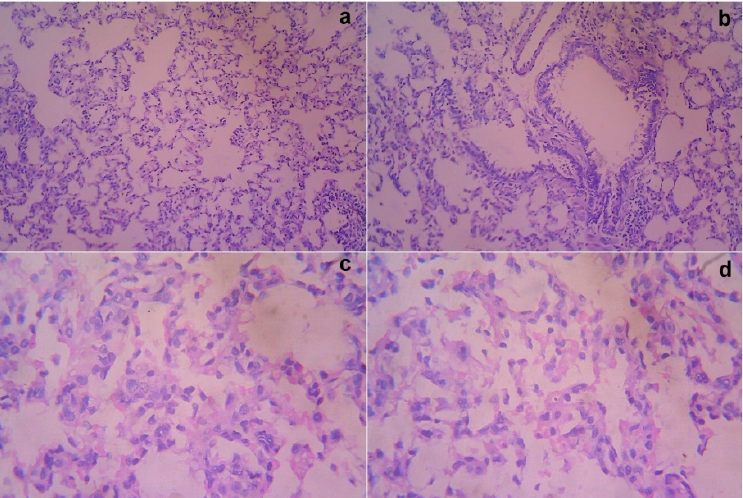
Figure 3. Gross histopathological examination of the lung following the infusion of mesenchymal stem cells obtained from decidua basalis in Wistar albino rats to assess the impact of safety, efficacy, and acute toxicity. Representative images of the lung section stand for ( a ) 10 × showing alveoli dilatation, ( b ) 10 × showing normal bronchi and peribronchiole, ( c ) 40 × showing mild dilatation of alveoli, and ( d ) 40× showing destructed architecture, respectively.